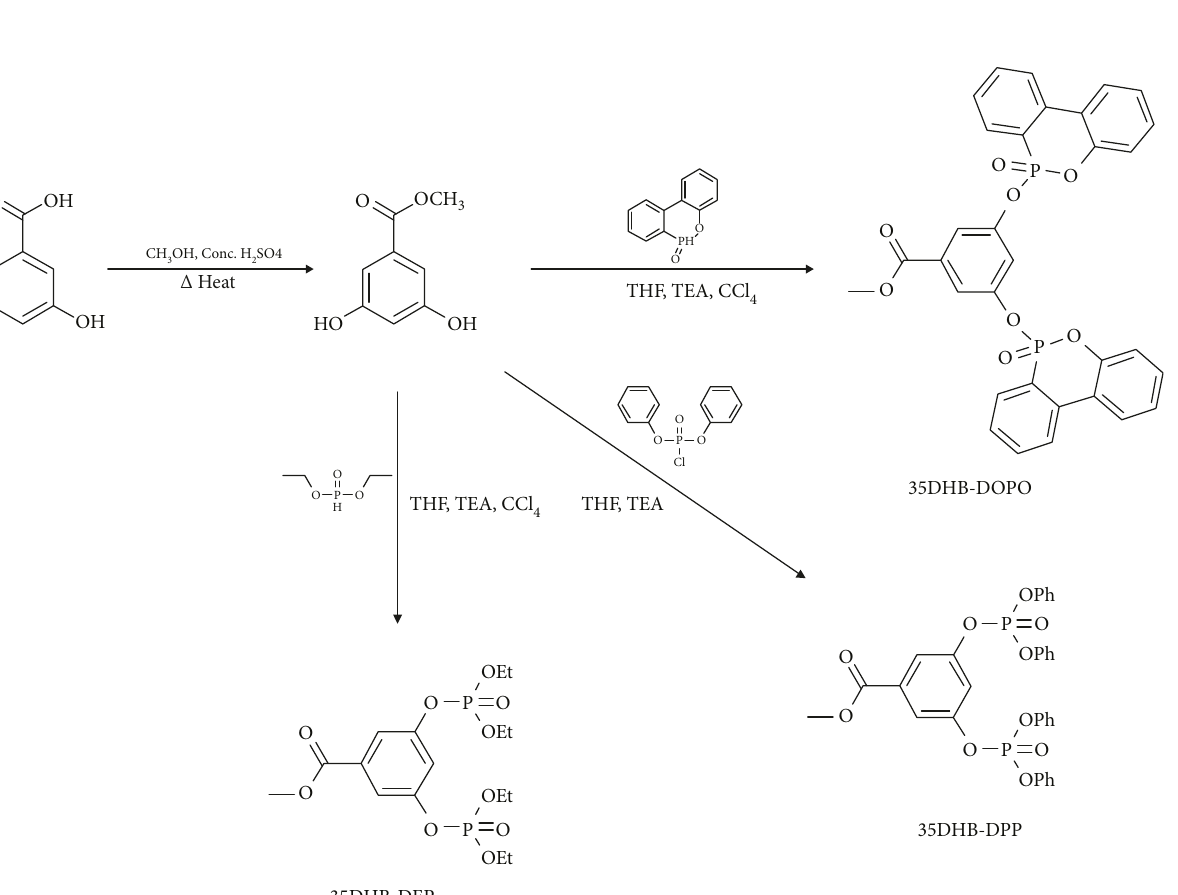
Scheme 2: Synthesis of phosphorus esters of methyl